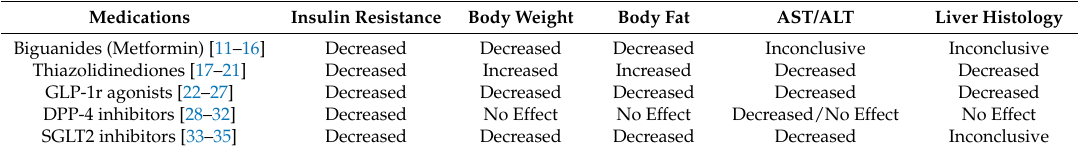
Table 1. Comparative efficacy of anti-diabetic agents for the treatment of NAFLD. Medications Insulin Resistance Body